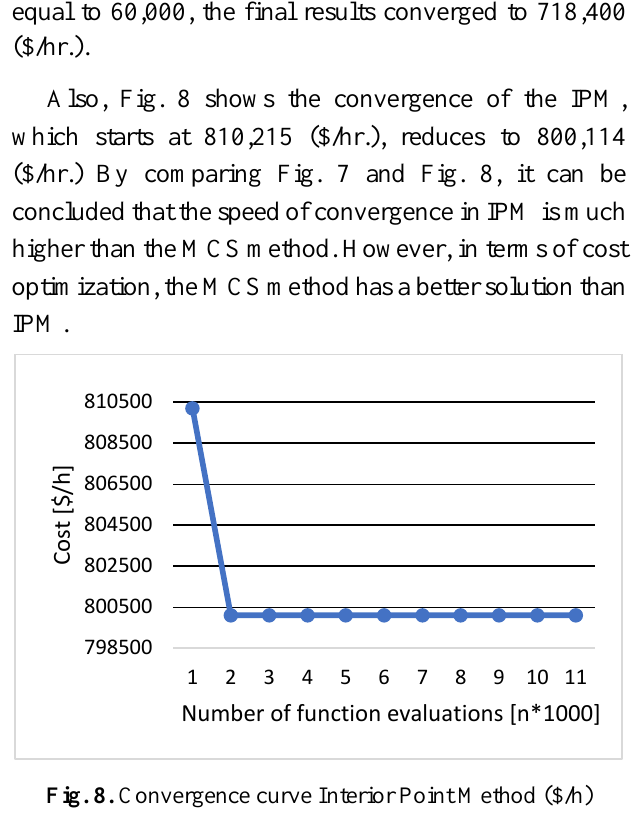
Fig. 8. Convergence curve Interior Point Method ($/h)